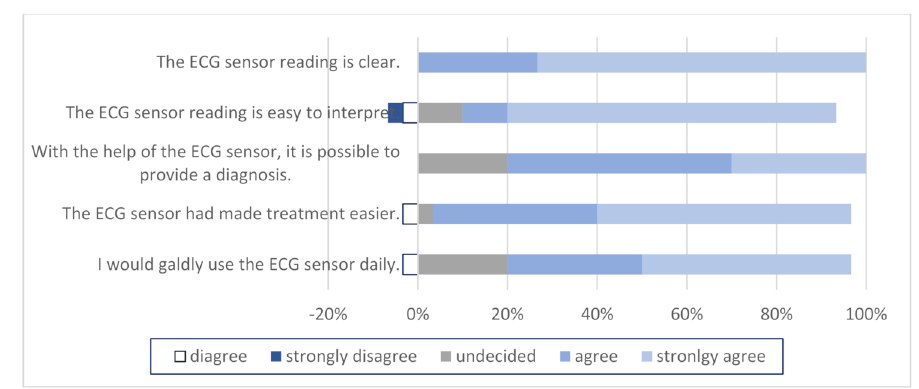
Figure 3. Patient satisfaction with ECG sensor